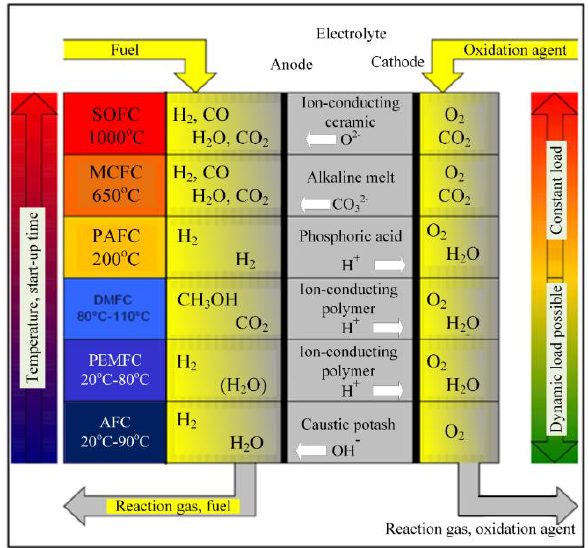
Figure 70. Different types of fuel cell technology at a glance; the abbreviations used for the different fuel cell technologies are: AFC—alkaline fuel cell, PEMFC—polymer electrolyte membrane fuel cell, DMFC—direct methanol fuel cell, PAFC—phosphor acid fuel cell, MCFC—molten carbonate fuel cell, SOFC—solid oxide fuel cell. [212].